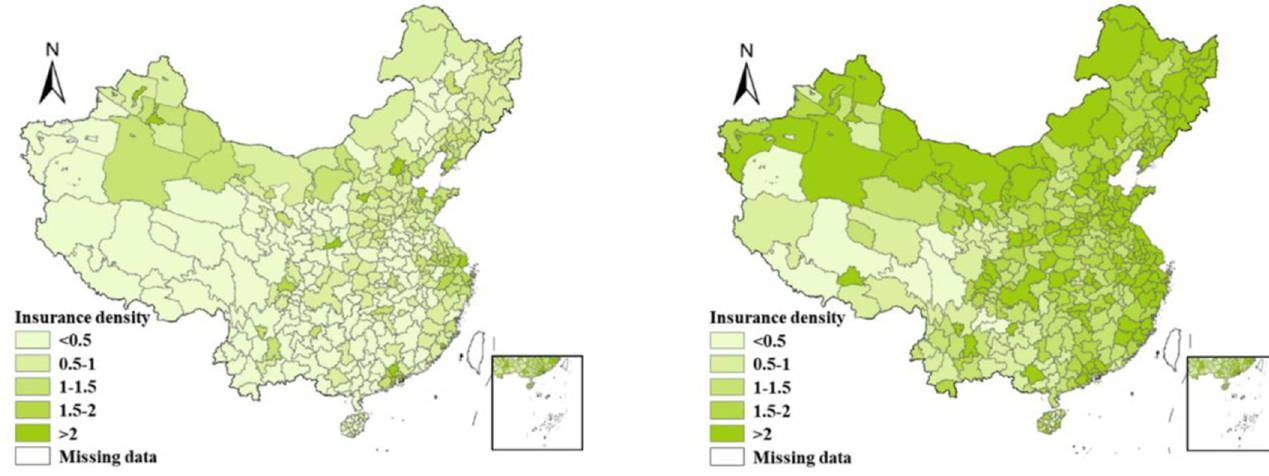
Fig 3. Insurance density of